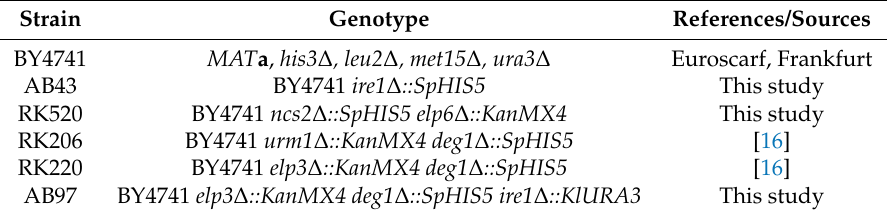
Table 1. Saccharomyces cerevisiae strains used in this study.